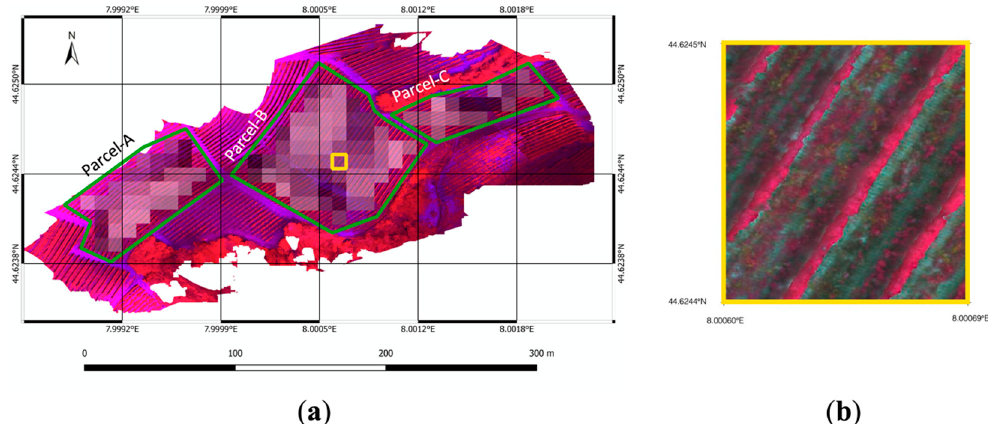
Figure 2. ( a ) Selected test field located in Serralunga d’Alba (Piedmont, northwest of Italy). The boundaries of the three considered parcels, named “Parcel-A”, “Parcel-B”, and “Parcel-C”, are marked with solid green polygons. The concurrent illustration of low resolution and high-resolution maps derived from satellite and UAV respectively is represented in false colors (near infrared, red, and green channels). ( b ) Enlargement of UAV imagery highlighted by the yellow square in Figure 1a. Table 2. Dataset acquisition details from the Sentinel-2 ( 𝑋 (cid:3045)(cid:3028)(cid:3050) ) and UAV ( 𝑌 (cid:3022)(cid:3002)(cid:3023) ) platforms.